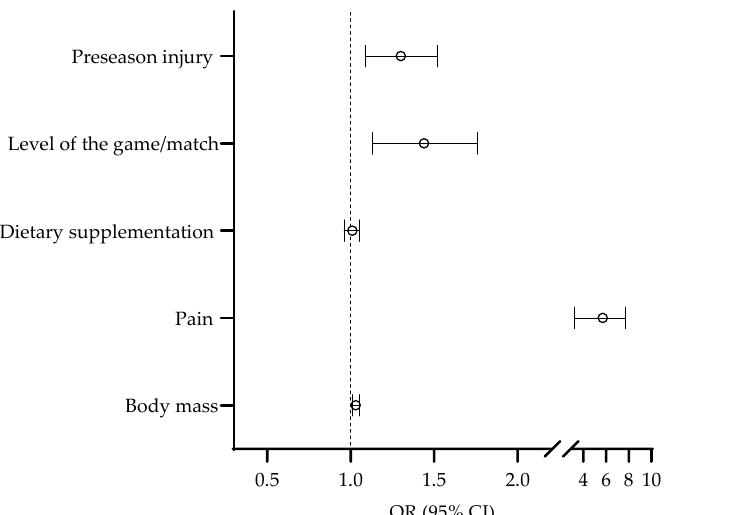
Figure 5. Multivariate associations between preseason injury occurrence, level of the game played, dietary supplementation, pain prevalence, and body mass with injury occurrence .